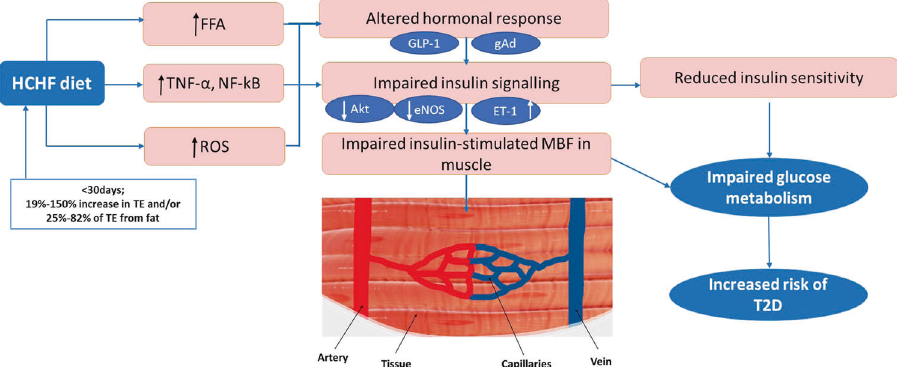
Fig. 1 Mechanisms through which short-term high-calorie and/or high-fat feeding may impair muscle microvascular blood fl ow and insulin sensitivity in humans leading to impaired glucose metabolism. TE, total energy, HCHF, high-calorie high fat, FFA, free fatty acids, TNF- α , tumour necrosis alpha, NF-kB, nuclear factor kappa-light-chain-enhancer of activated B cells, GLP-1, glucagon-like peptide, gAd, globular adiponectin, Akt, protein kinase B, eNOS, endothelial nitric oxide synthase, ET-1, endothelin-1, MBF, microvascular blood fl ow, ROS, reactive oxygen species, T2D, type 2